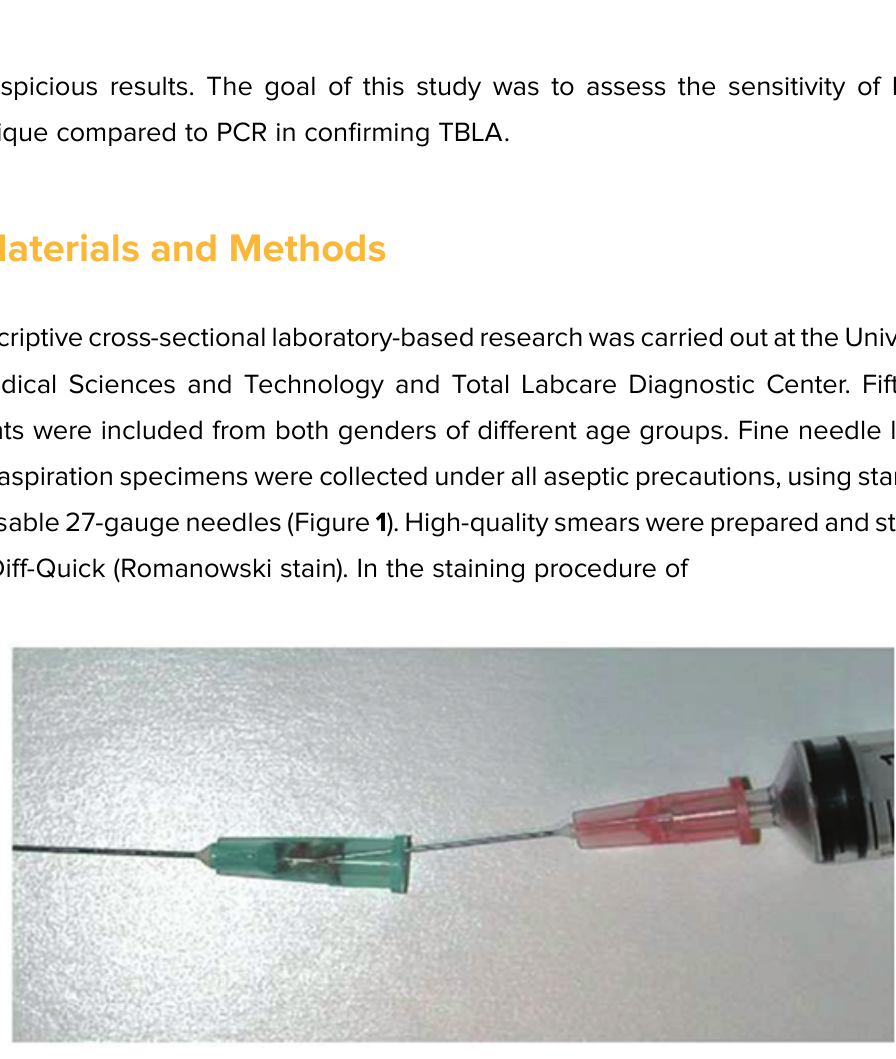
Figure 1 : Collection of a sample trapped in the hub of the biopsy needle, the sample was aspirated with another needle mounted on a